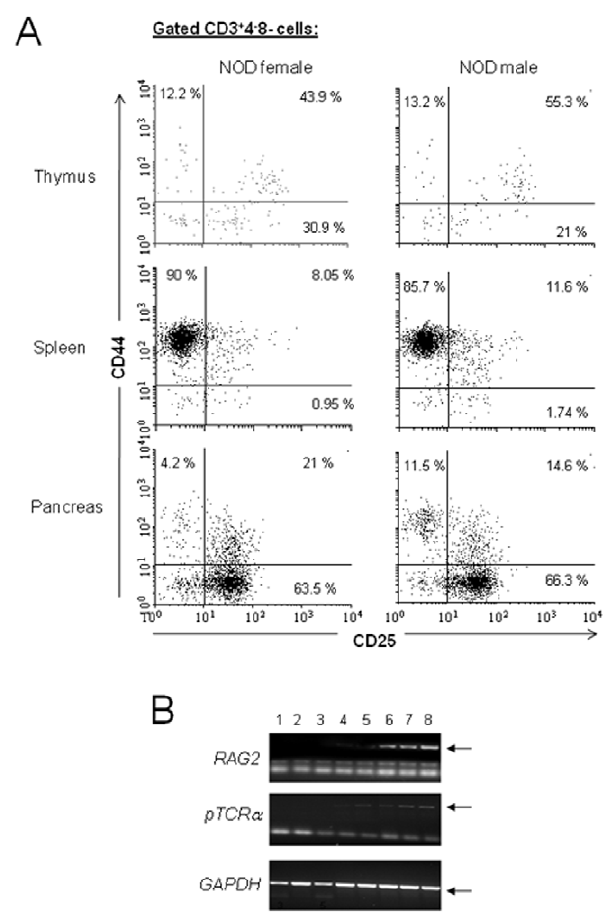
Figure 4. In Vivo detection of markers for NOD DNCD3 cell differentiation. Panel A , Single-cell suspensions isolated by tissue douncing of total thymocytes and splenocytes from 14 day-old individual NOD females and males from two different litters (n=5 mice per gender), as well as pancreatic lymphocyte infiltrates from 4–5 month-old individual pre-diabetic NOD females were stained with CD3- Alexa 700, CD4-PE-Cy7, CD8-PerCP, CD25-APC, and CD44-FITC mAb- conjugates, and analyzed by FACS. Shown are the mean values (percent) of CD44 vs. CD25 expression on DNCD3 cells in each organ and gender 6 SD. Panel B , patterns of RAG2 (upper panel) and pre- TCR a (middle panel) mRNA expression detected by RT-PCR in the FACS- sorted thymic, splenic and pancreatic infiltrating DNCD3, DP, and mature SP4 T-cell subsets from a pool of 4 to 5 month-old, pre-diabetic NOD female mice (n=6), as described. Lane 1 , SP4 pancreatic infiltrating cells; lane 2 , SP4 splenocytes; lane 3 , SP4 thymocytes; lane 4 , DP pancreatic infiltrating cells; lane 5 , DP thymocytes; lane 6 , DNCD3 pancreatic infiltrating cells; lane 7 , DNCD3 splenocytes; and lane 8 , DN thymocytes. Lower panel shows the corresponding GAPDH mRNA amplicons analyzed in the upper and middle panels. Arrows indicate the presence of RAG2, pTCR a , and GAPDH